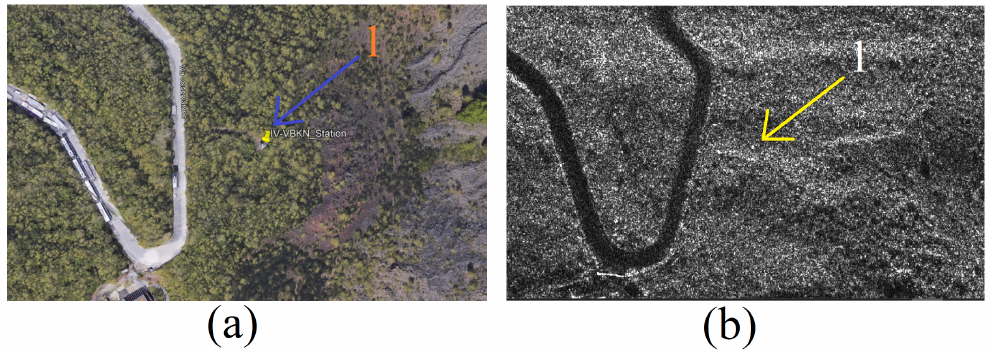
Figure 18. IV-VCRE seismograph station, located on the east side of the crater. ( a ) Optical image. ( b ) SAR image.